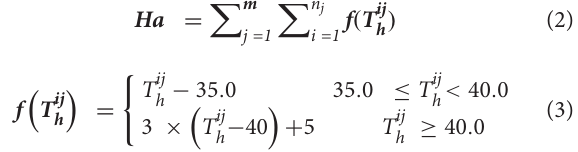
Frontiers in Earth Science |